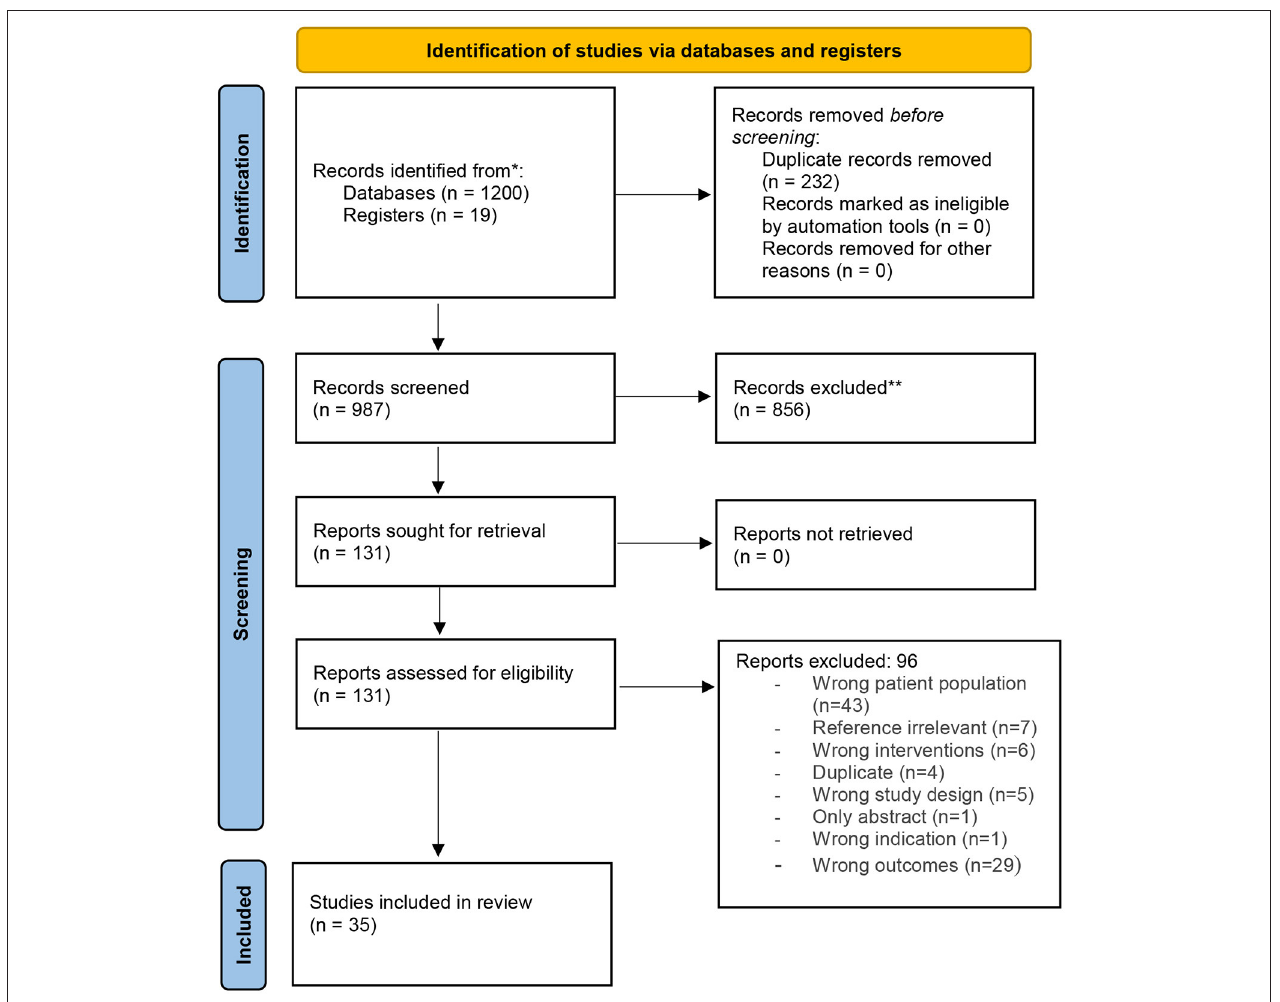
FIGURE 1 | PRISMA for digital